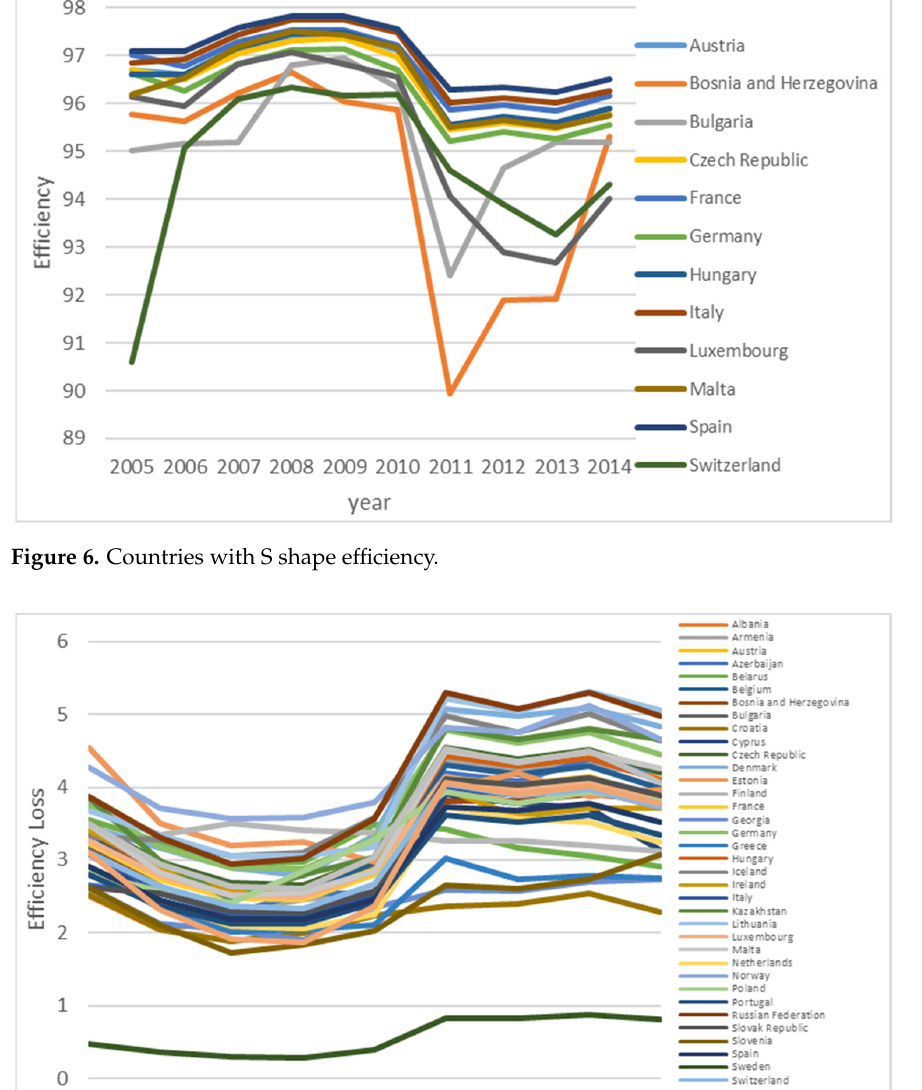
Figure 5. Countries with consistent efficiency improvement over time.